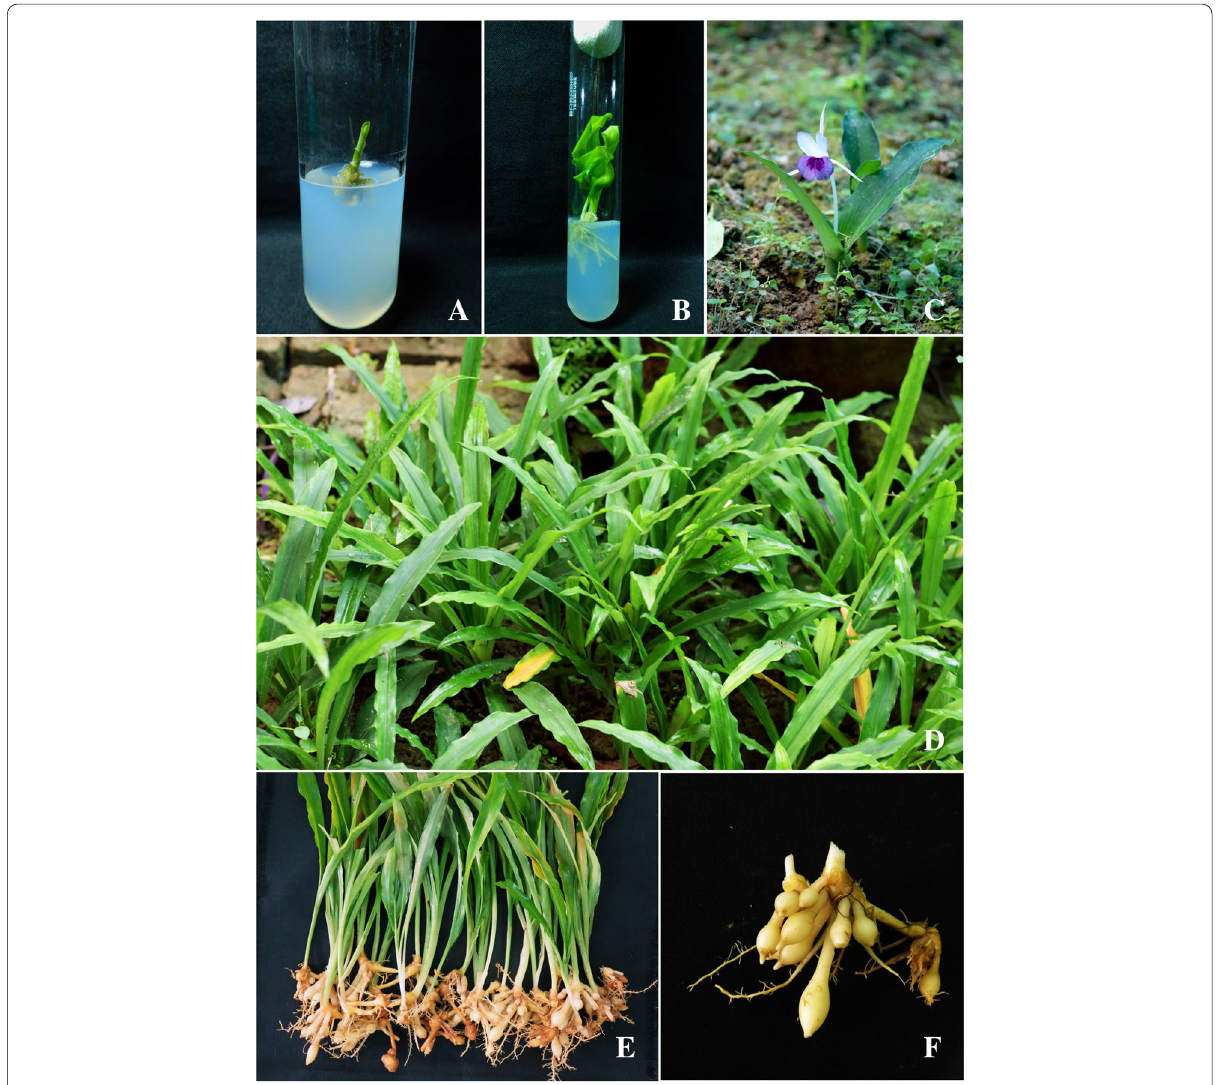
Fig. 1 The plant Kaempferia angustifolia . A In vitro inoculation of the plant. B In vitro propagation of the plant. C Ex vitro flowering of the plant